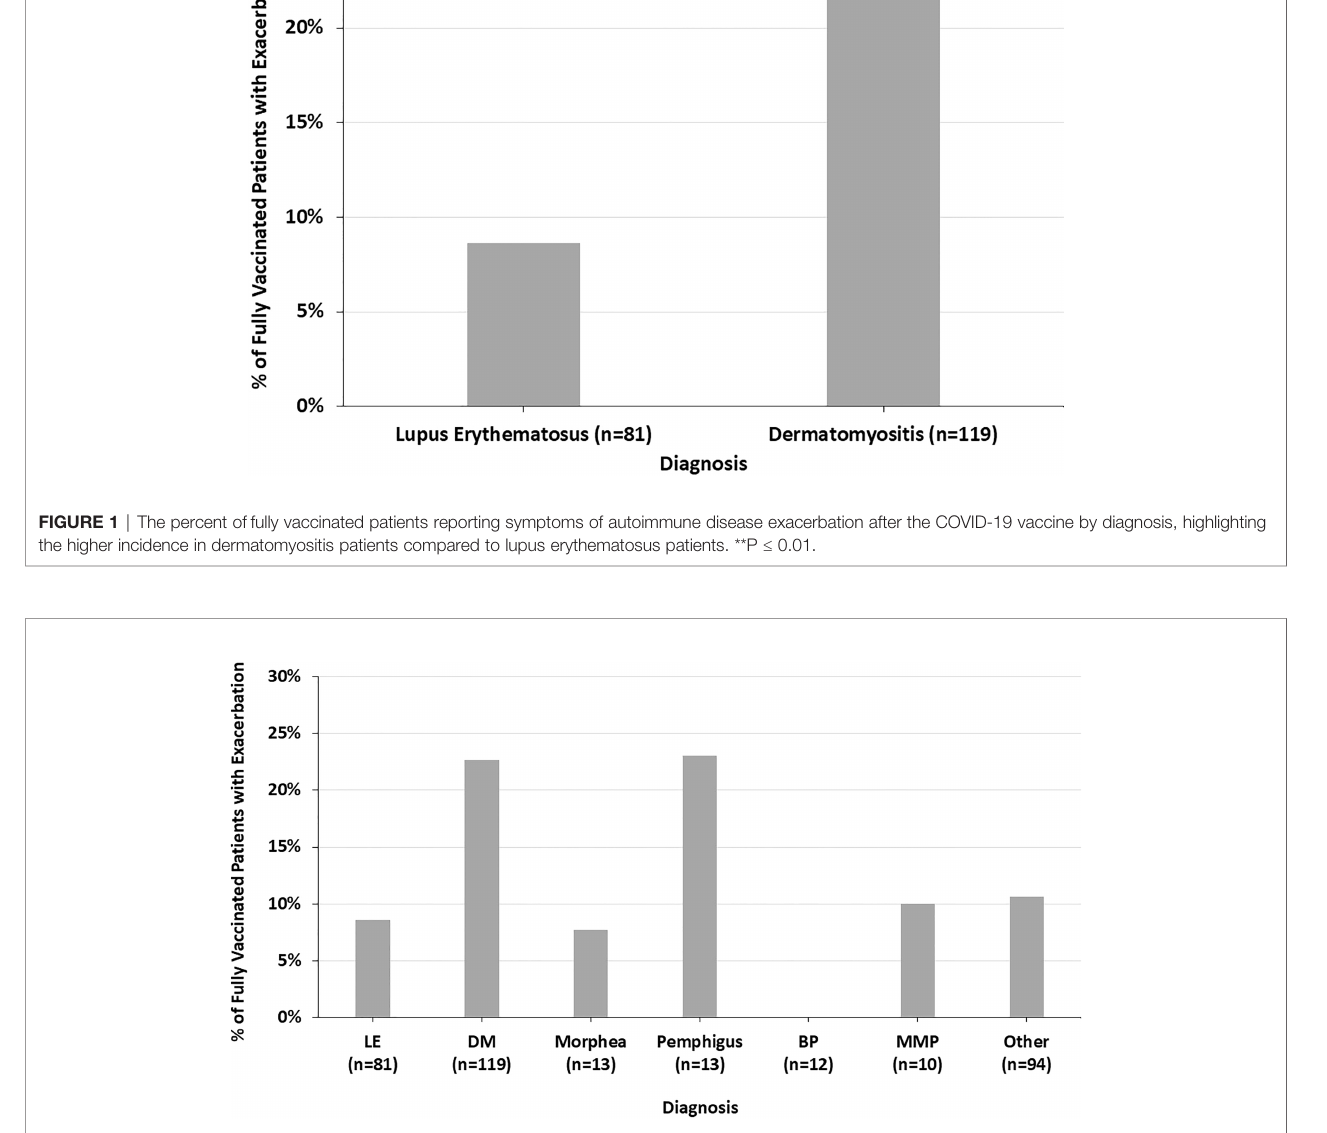
FIGURE 2 | The percent of fully vaccinated patients reporting symptoms of autoimmune disease exacerbation after the COVID-19 vaccine by diagnosis, highlighting the variation across all diagnoses